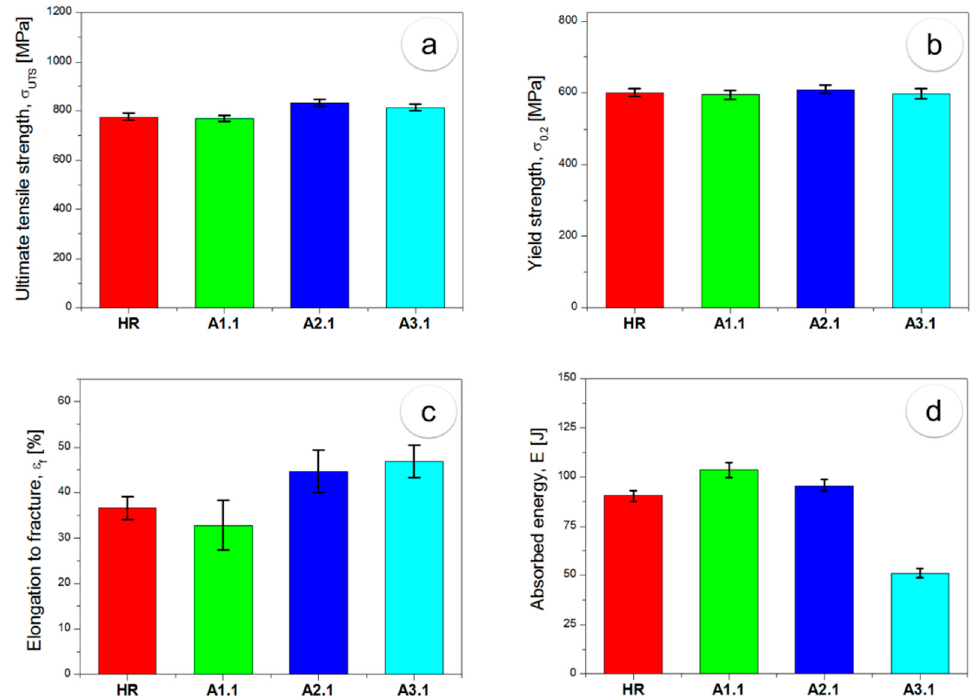
Figure 8. Comparative representation of mechanical properties for the hot-rolled ( HR ) and short-duration aging treatments A1.1 , A2.1, and A3.1 states for ultimate tensile strength ( a ), yield strength ( b ), elongation to fracture ( c ), and absorbed energy ( d ).